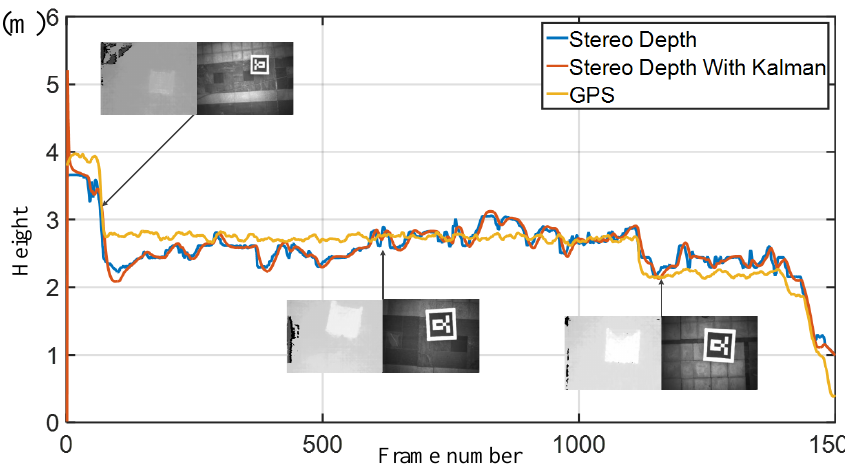
Figure 13. Comparison of UAV altitude estimation. Blue, red, and yellow represent the stereo depth estimation results, the stereo depth estimation results with Kalman filtering, and the ground truth of the GPS, respectively.